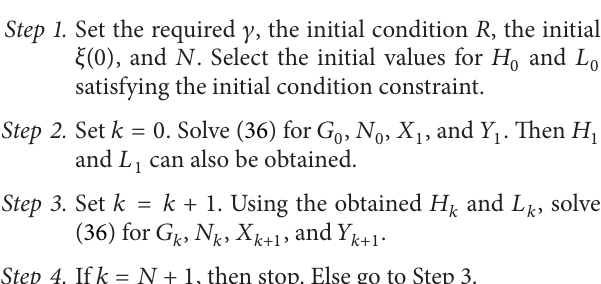
Algorithm 10 ( 𝐻 ∞ filter design algorithm).